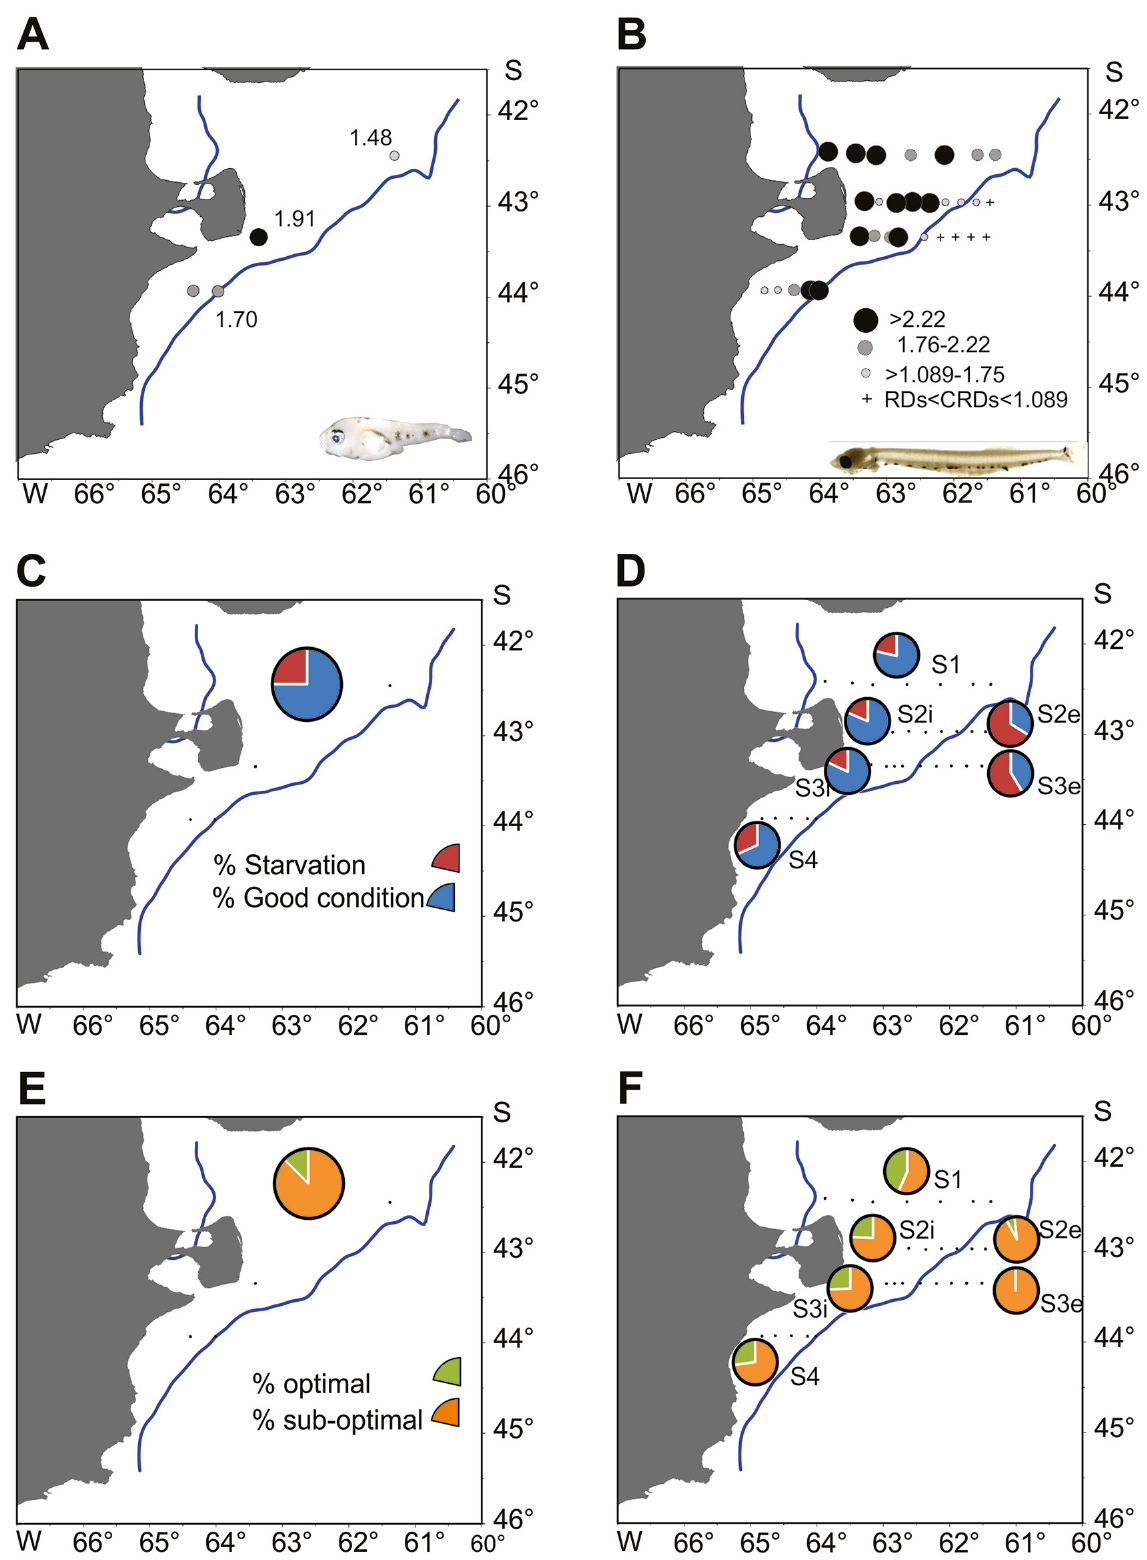
Fig. 5. –Average standardized RNA/DNA index (RD) obtained for each station studied for larvae of the hake Merluccius hubbsi (A) and the anchovy Engraulis anchoita (B). The size of the circles is proportional to the RD values obtained. Spatial distribution of the percentages of individuals below the critical standardized RNA/DNA index (CRD), i.e. in starvation, in red for (C) Merluccius hubbsi larvae and (D) Engraulis anchoita larvae and the percentage of individuals above the optimal Gpf (Gpf>1) in green, that is, in sub-optimal condition, for (E) hake Merluccius hubbsi larvae and (F) anchovy Engraulis anchoita larvae. Dots in (C) to (F) indicate the stations where the fish larvae were caught. S1, S2i, S2e, S3i, S3e, S4: oceanographic sections grouping the internal and external stations in relation to the position of the tidal front (blue